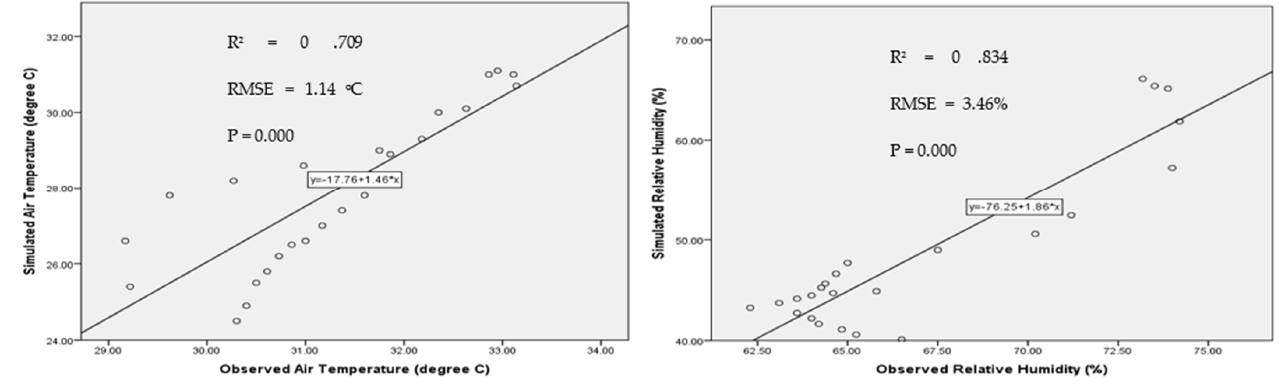
Figure 8. Regression of ENVI-met validation between measured and simulated air temperature ( left ) and RH ( right ) at FBTS.